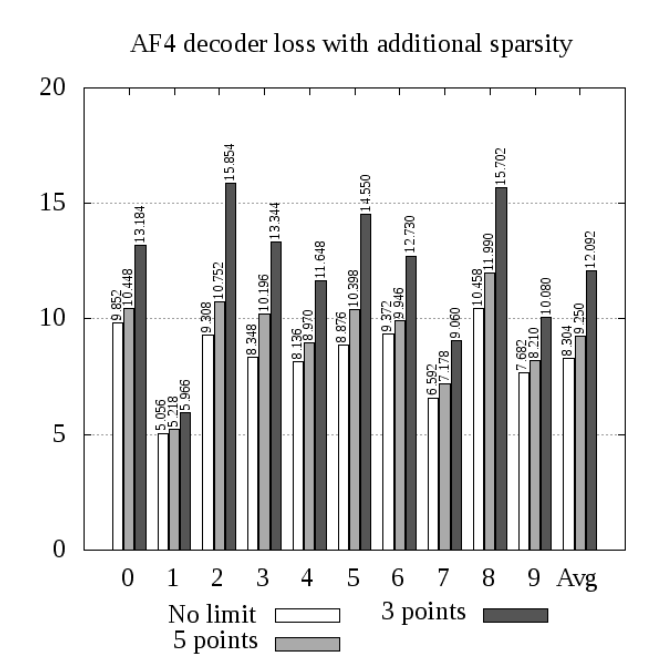
Figure 5. The pretrained decoder from AF4 used for decoding of both the original and the highly sparse data, as in Figure 4.